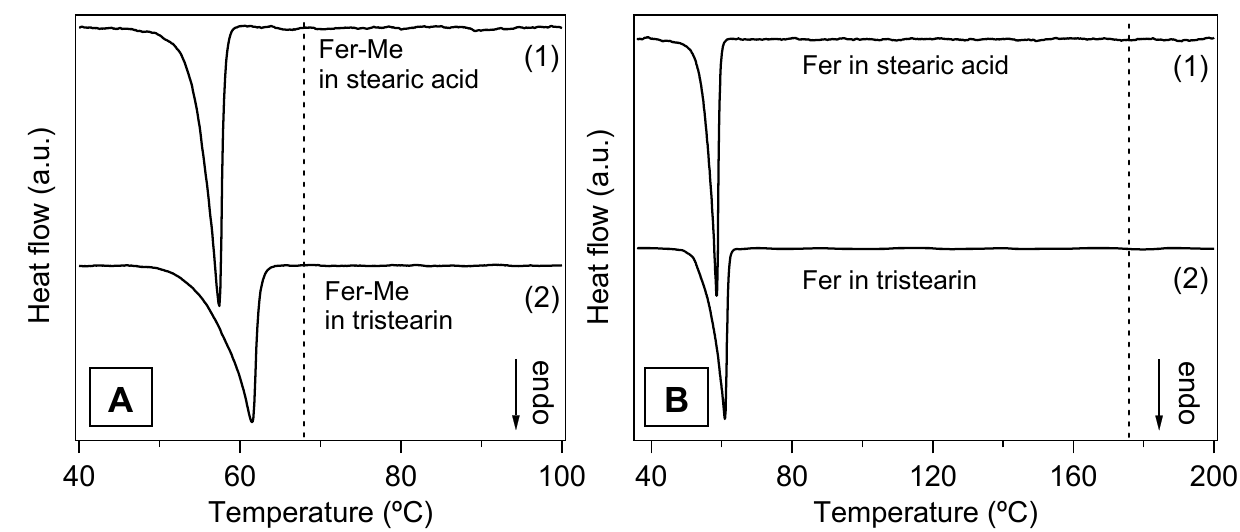
Figure 9. DSC curves of the SLMs. ( A ) Stearic acid SLMs loaded with Fer-Me (Fer-Me in stearic acid) (1) and tristearin SLMs loaded with Fer-Me (Fer-Me in tristearin) (2); the vertical dashed line marks the temperature T P for the pure Fer-Me. ( B ) Stearic acid SLMs loaded with Fer (Fer in stearic acid (1) and tristearin SLMs loaded with Fer (Fer in tristearin) (2); the vertical dashed line indicates T P of the pure Fer. The curves are displaced along the vertical axis for better visualization.